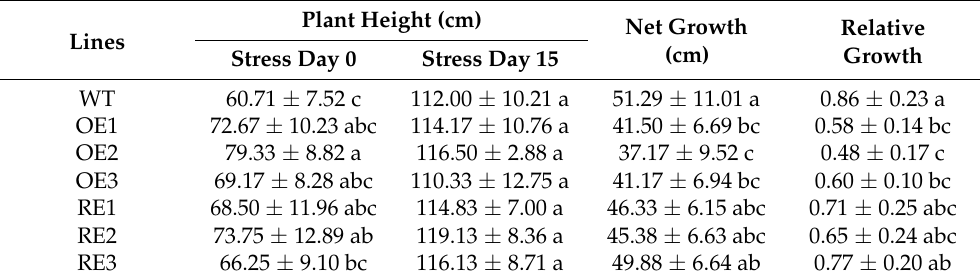
Table 1. The difference of plant height growth among OE, RE and WT lines under NaHCO 3 stress